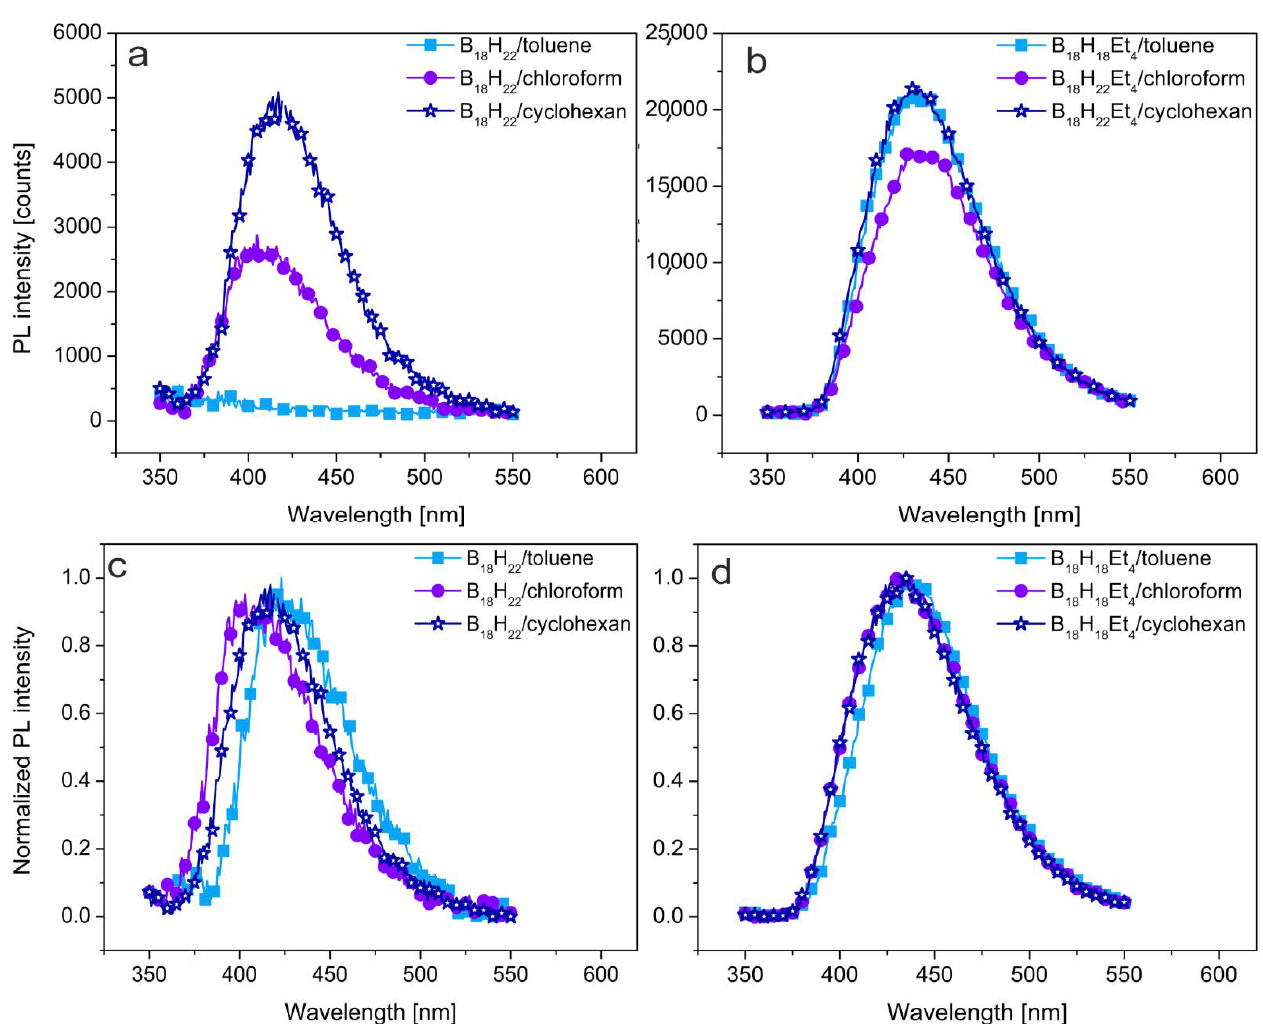
Figure 2. Photoluminescence emission spectra of ( a ) anti -B 18 H 22 and ( b ) 3,3′,4,4′-Et 4 - anti -B 18 H 18 in solutions, ( c , d ) are their normalized form. Excitation wavelength λ exc = 340 nm for all samples.